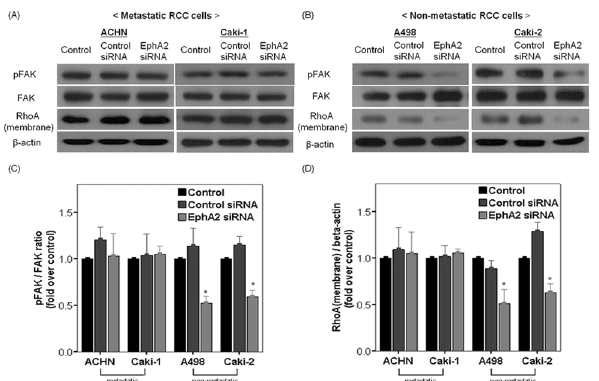
Fig 7. Effect of EphA2 siRNA on FAK phosphorylation and expression of membrane-bound RhoA in RCC cells. Representative immunoblots for pFAK, FAK, RhoA (membrane) and β -actin from untreated cells (control), control siRNA treated cells and EphA2 siRNA treated cells at 48 hours after treatment in (A) metastatic RCC cell lines (ACHN and Caki-1) and (B) non-metastatic RCC cell lines (A498 and Caki-2). Comparison of FAK phosphorylation (C) and the expression of RhoA (membrane) protein (D) among the three groups in each cell line. The results were normalized by β -actin expression and presented as fold changes over controls. * p < 0.05 vs. control and control siRNA treated groups. siRNA = small interfering RNA, RCC = renal cell carcinoma.